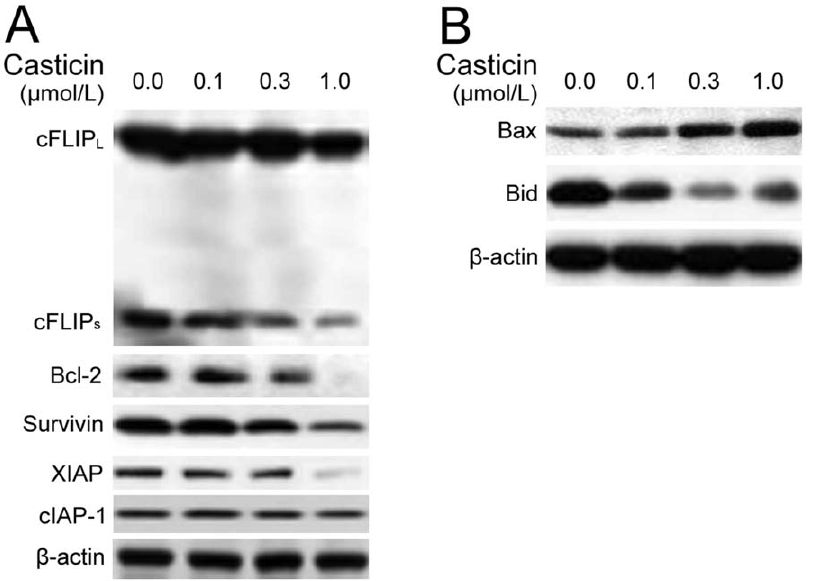
Figure 8. Effects of casticin on the expression of proteins involved in apoptosis. BGC-823 cells were treated with casticin at the indicated concentrations for 24 h. Western blot analysis was used to determine the expression levels of anti-apoptosis proteins (cFLIP, Bcl-2, XIAP, cIAP-1 and survivin) and pro-apoptosis proteins (Bax and Bid). b -actin was used as the loading control.